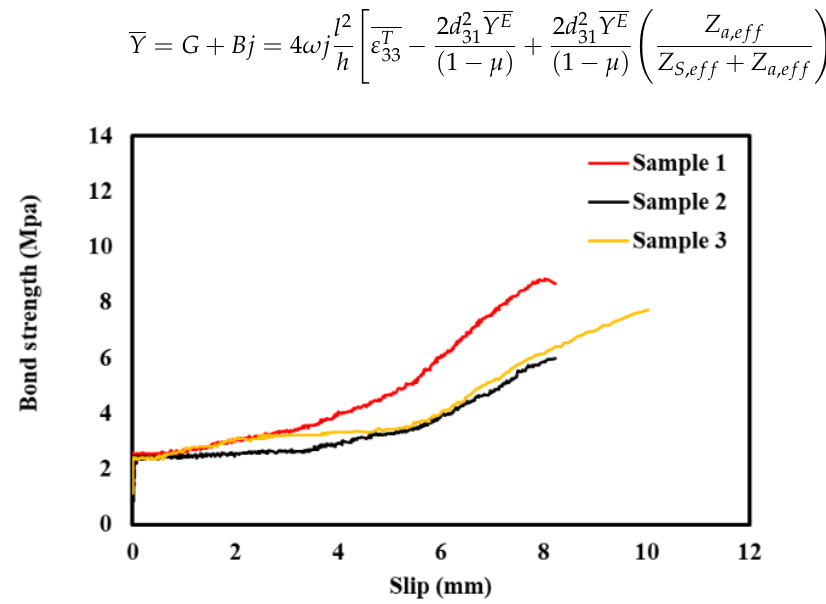
Figure 9. Test results for bond strength vs Slip curve.